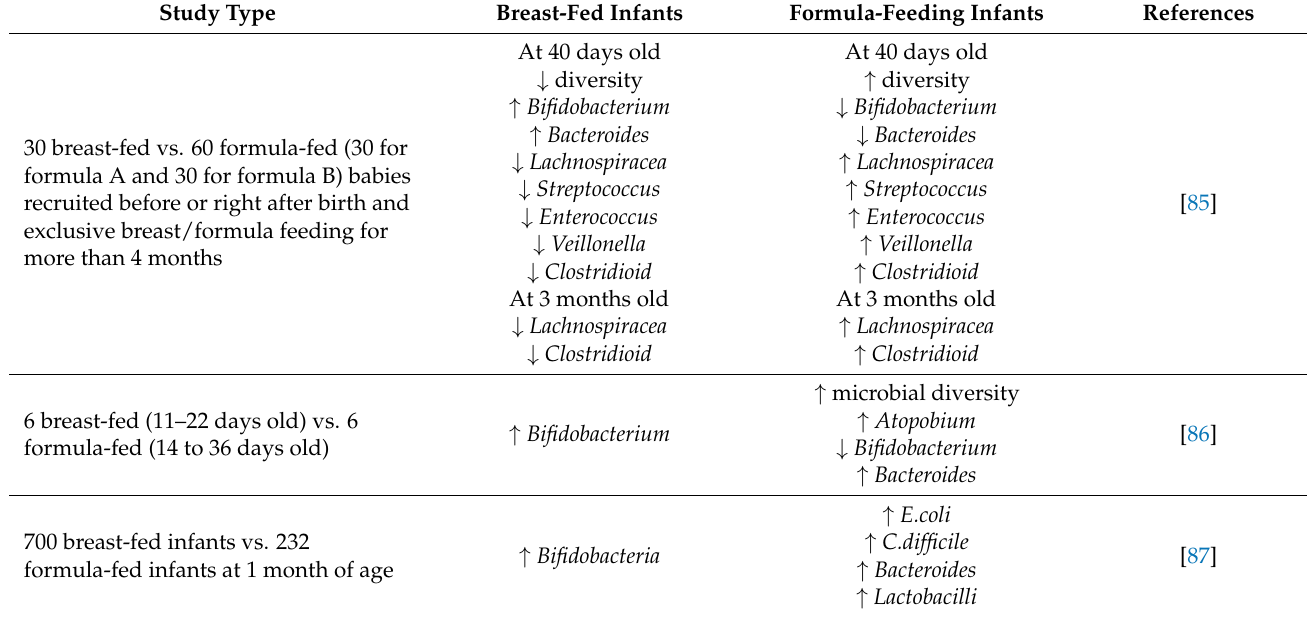
Table 2. A summary of studies exploring the gut microbiota difference between breast-fed and formula-fed infants. Study